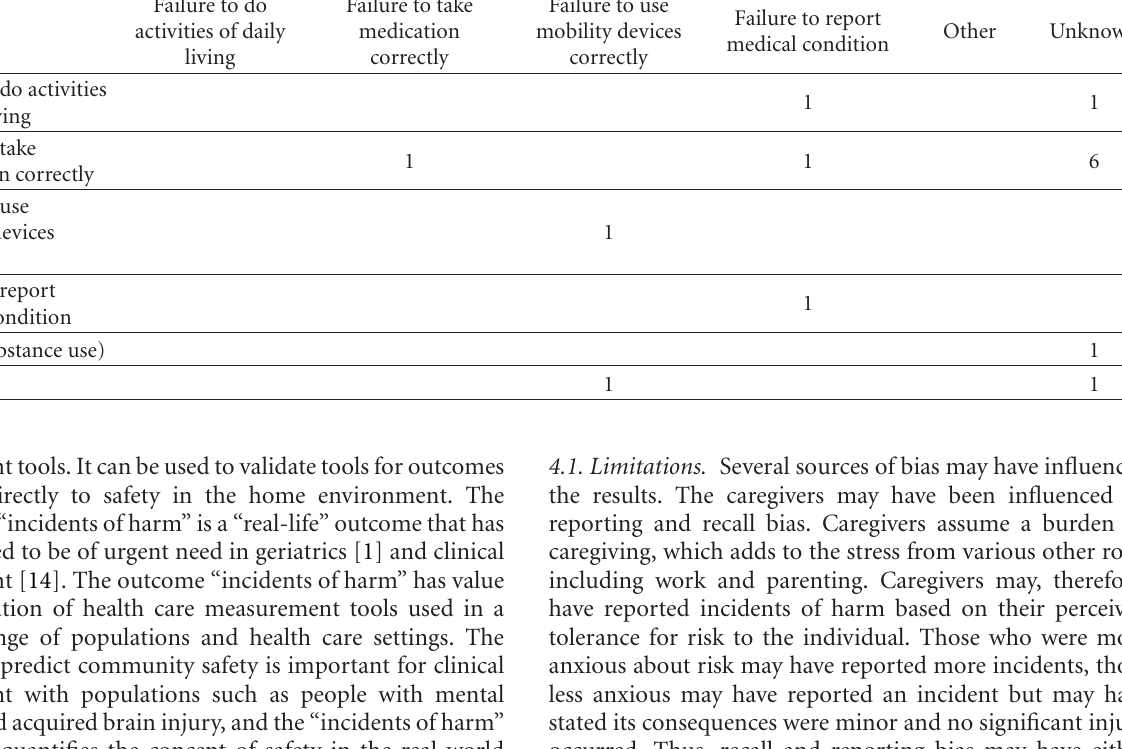
Table 3: Validity comparison between caregiver and medical chart on type of incident (incidents requiring medical attention only). Type described